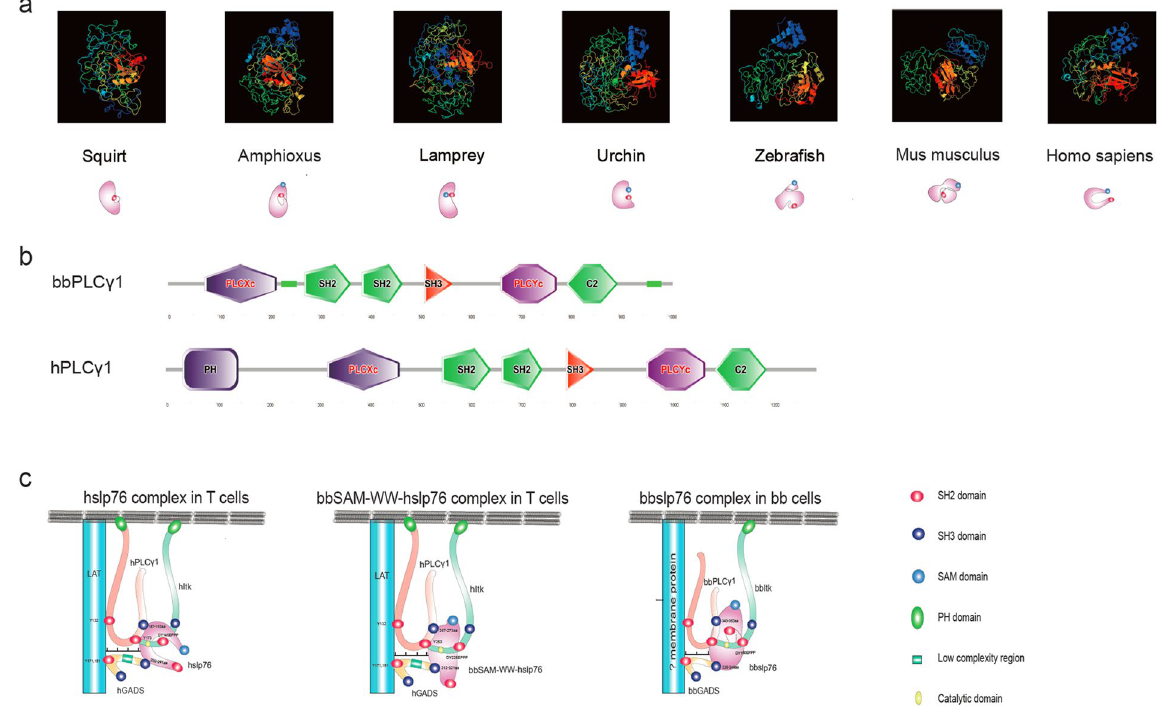
Figure 8. 3D model comparison of slp76 from several keystone species. ( a ) 3D model comparison of slp76 from several keystone species. The 3D structures were predicted by Phyre2. ( b ) Protein structures of bbPLC γ 1 and hPLC γ 1generated by SMART. ( c ) A web of interactions connects hslp76 to the hPLC γ 1, hItk, hLAT and hGADS. Predicted interactions of bbSAM-WW-hslp76 in T cells and bbslp76 in bb cells. Scales show the distance between LAT and